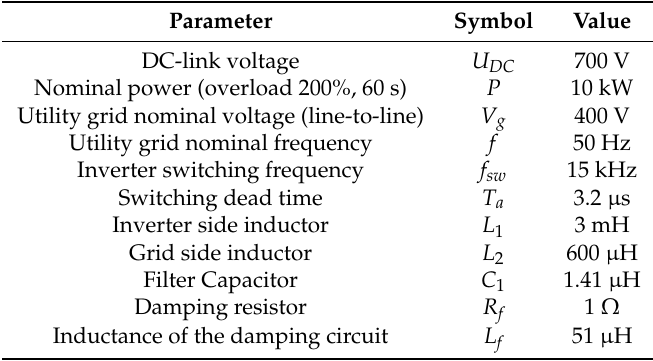
Table 1. Inverter nominal values.